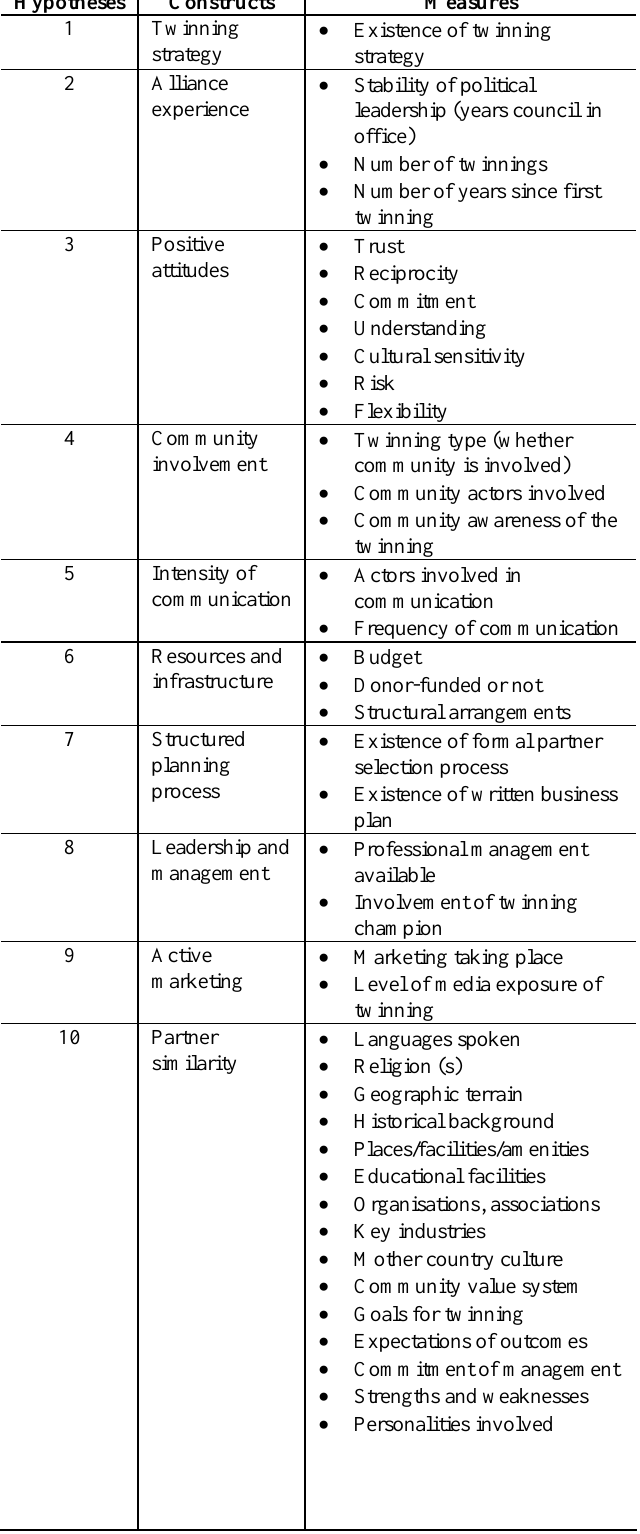
Table 1: Constructs and